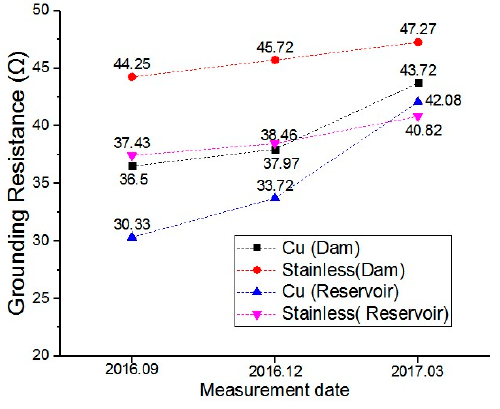
Figure 7. Grounding resistances of floating PV systems at the dam and reservoir (temperature corrected).